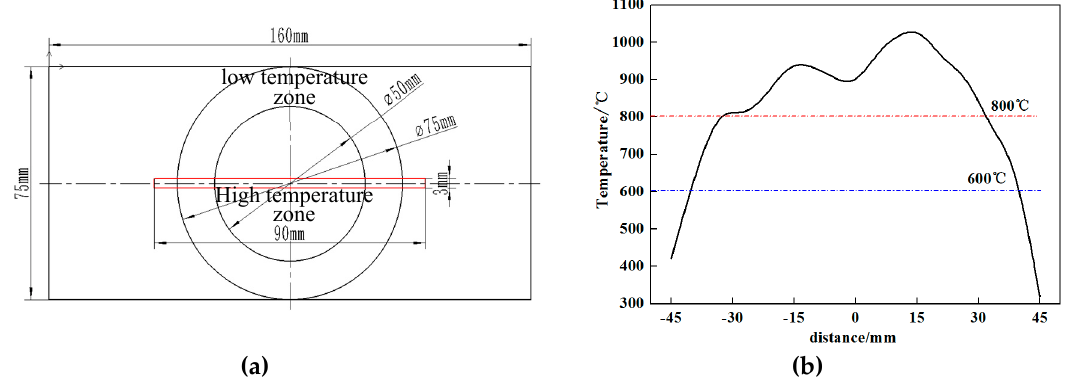
Figure 4. Temperature distribution of sheet after selective heating. ( a ) Top view: the red rectangle is the axial temperature measurement area. This area is taken as a microstructure characterization sample; ( b ) central axis: temperature is measured along horizontal axis.